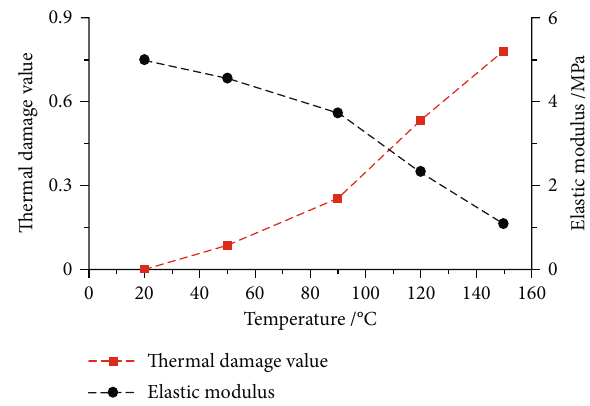
Figure 12: Damage variable curves of salt rock at di ff erent temperatures.